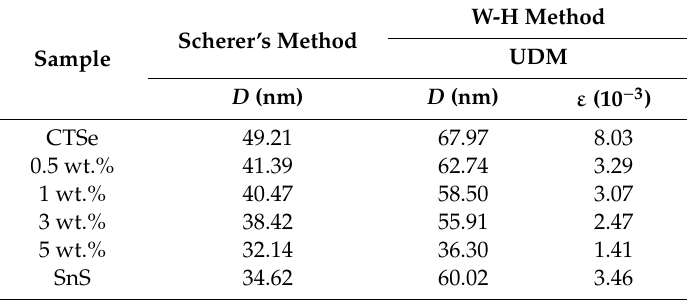
Table 1. Geometric parameters of the spark plasma sintered Cu 2 SnSe 3 , SnS, and Cu 2 SnSe 3 -SnS composites. UDM: uniform distribution model.